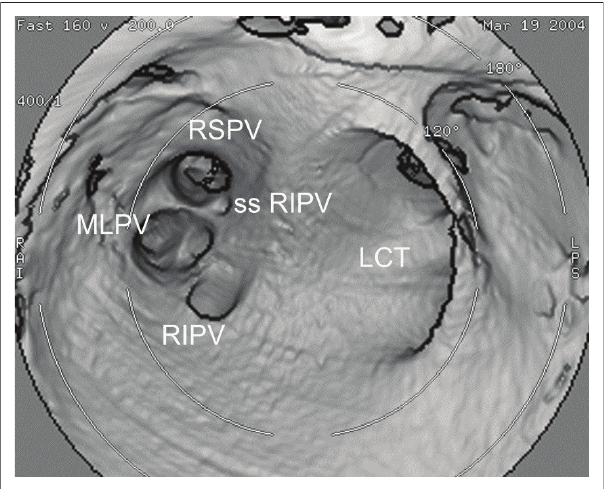
RSPV, right superior pulmonary vein; MLPV, middle lobe pulmonary vein; RIPV, right inferior pulmonary vein; ss RIPV, superior segment right inferior pulmonary vein; LCT, left common trunk. FIGURE 11: Combination of supernumerary veins with a common trunk. There is a middle lobe vein draining directly into the left atrium and an accessory vein draining the superior segment of the right lower lobe in addition to the right inferior pulmonary vein and common left trunk, endocardial view. Right superior pulmonary vein (RSPV), middle lobe pulmonary vein (MLPV), right inferior pulmonary vein (RIPV), accessory right inferior pulmonary vein draining the superior segment of the right lower lobe (ss RIPV) and left common trunk (LCT).